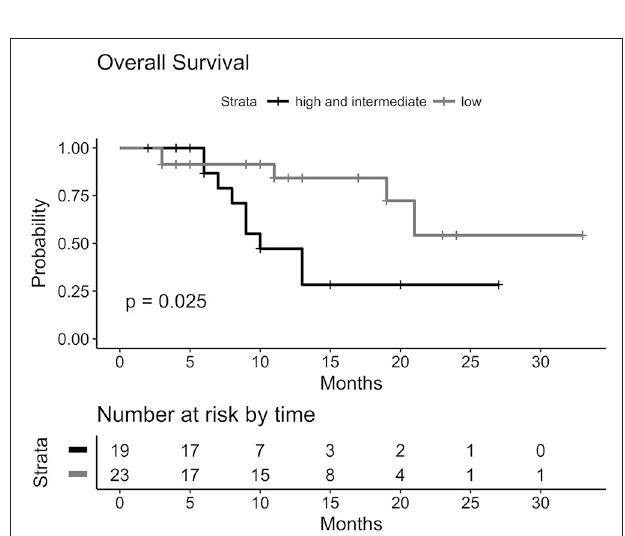
FIGURE 5 | Kaplan-Meier-Plot for Overall Survival grouped by BMV risk group. For low-risk group median OS has not been reached after first DBF. Combined intermediate /high-risk group: median OS of 10 months (95%CI: